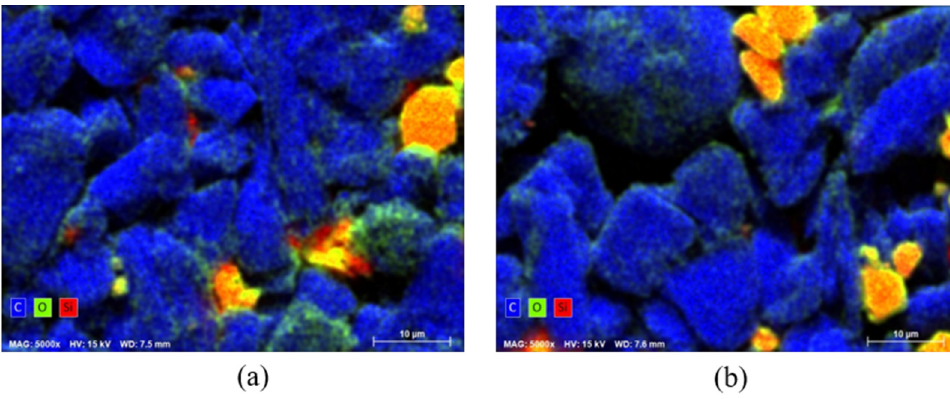
Figure A5. EDX mapping at 5000× magnification. ( a ) New anode; ( b ) cold aged anode cycled at 1 C and 0 °C.